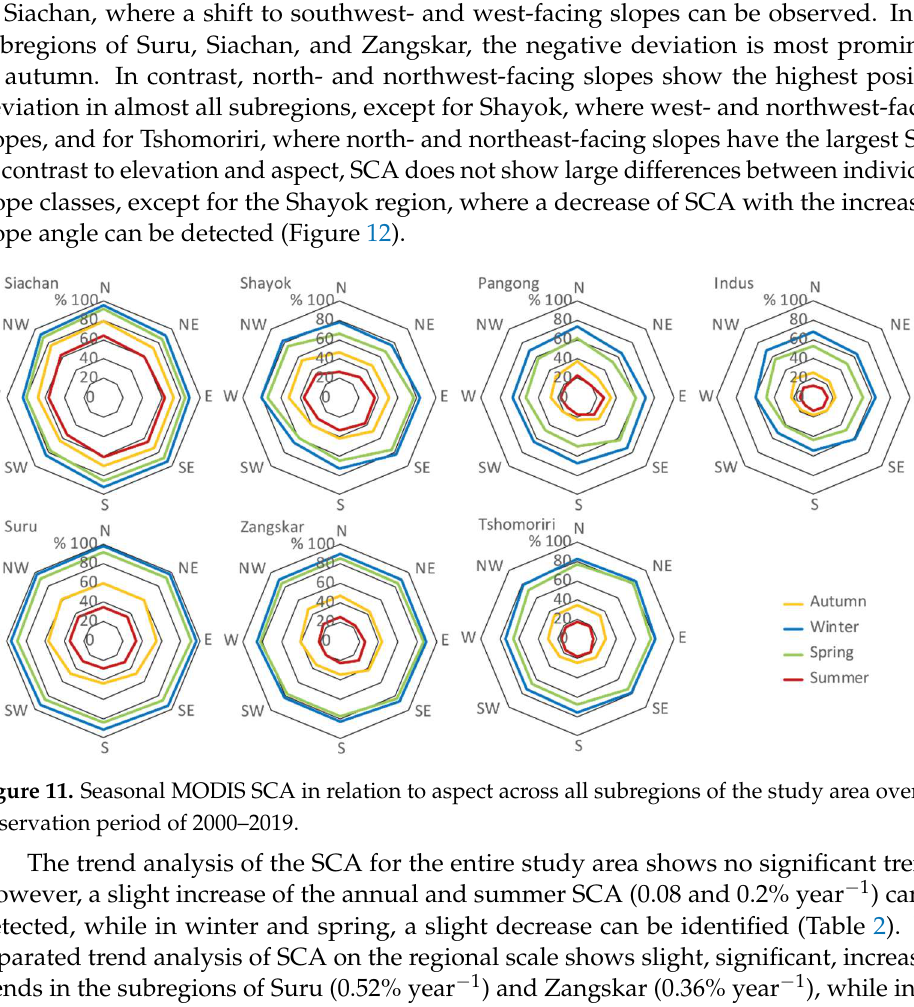
Figure 12. Seasonal and annual MODIS SCA and trends in relation to slope across all subregions over the observation period of 2000–2019.